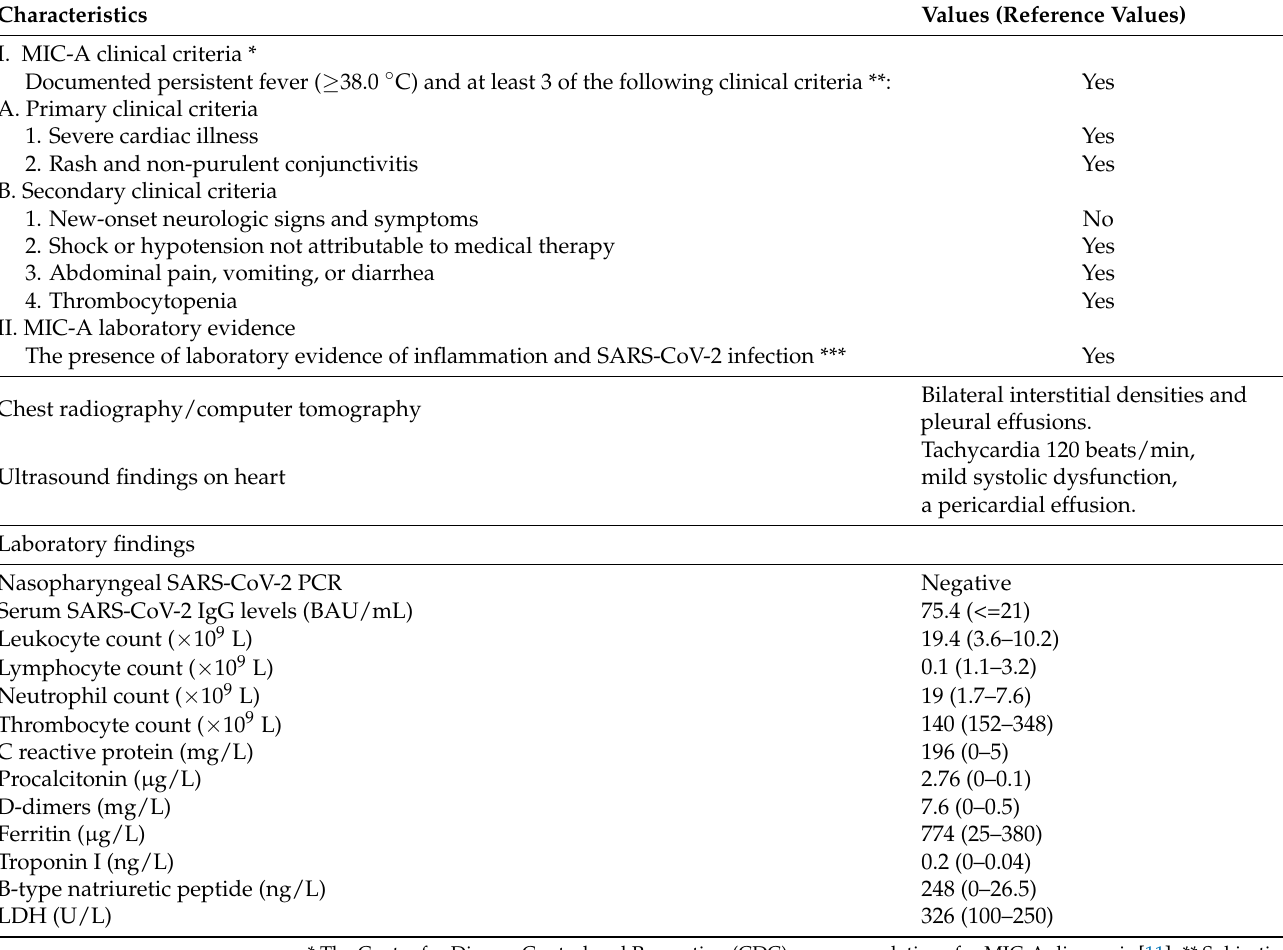
Table 1. Clinical and biological characteristics of the patient (on the day of admission to the hospital (emergency